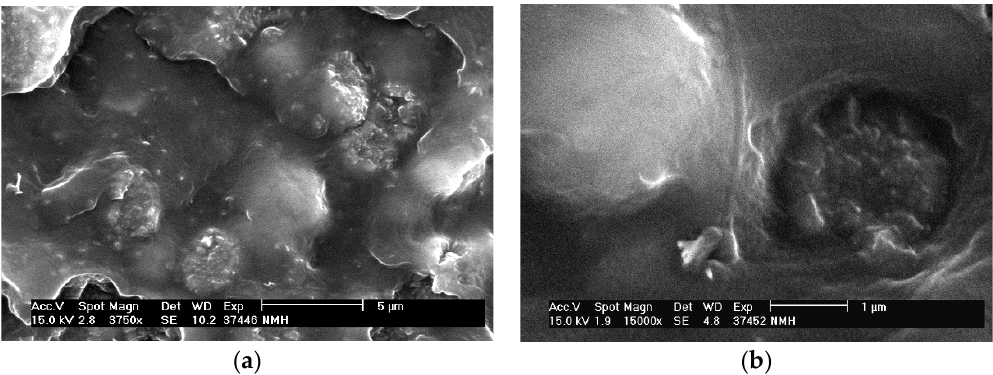
Figure 3. ( a ) The SEM micrograph of the notched specimens broken in a three-point bending in liquid nitrogen depicting the rubbery CMPs embedded in the ICPP matrix and revealing the porosity contained solely within the CMPs. ( b ) At larger magnification, good interfacial adhesion between the rubbery CMP and the ICPP matrix is observed.